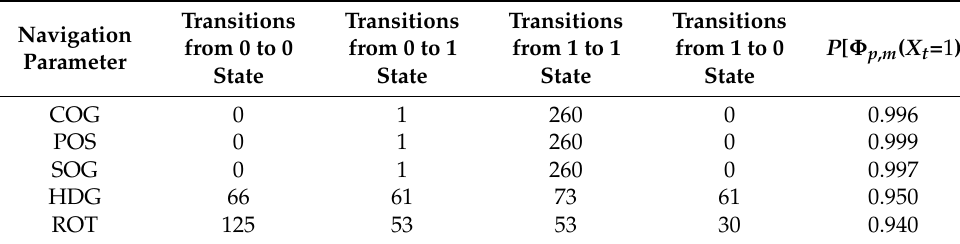
Table 3. Results of the system categorization into the state in set X ( t ) and the probability of remaining in state 1 for navigational parameters: COG, POS, SOG, HDG,